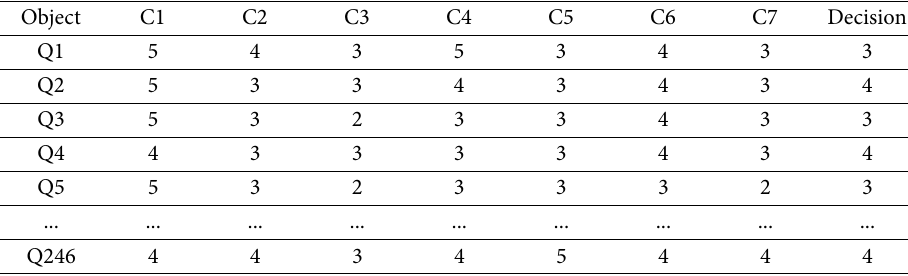
Table 4. Risk dimensions decision matrix